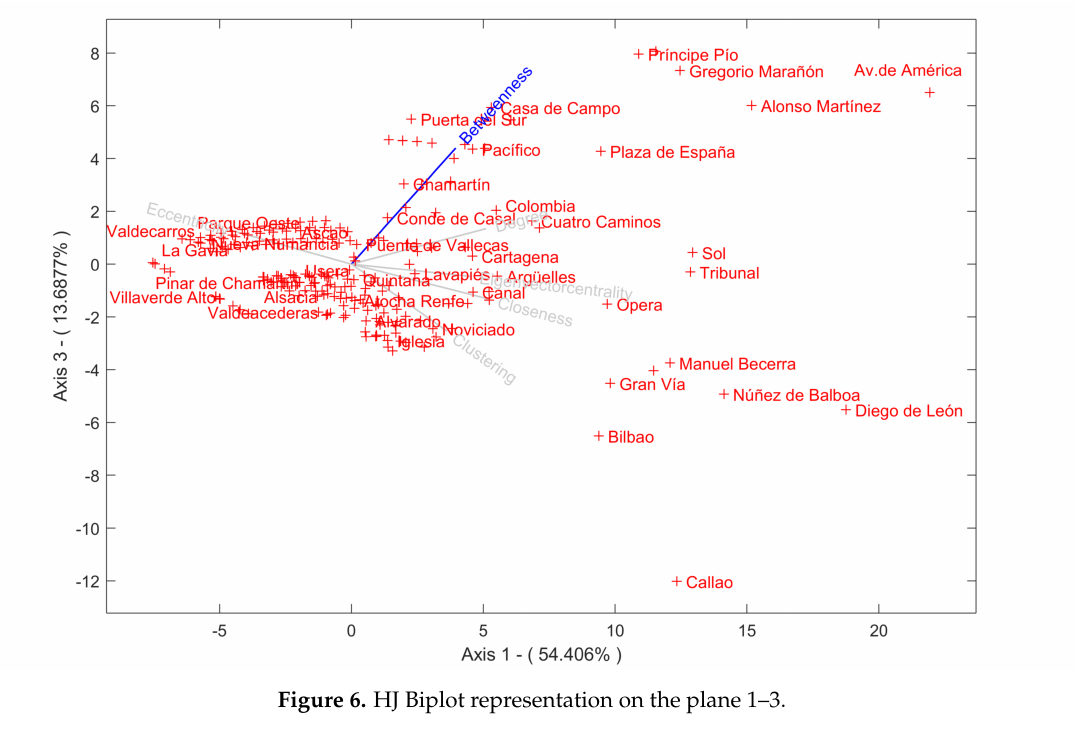
Figure 6. HJ Biplot representation on the plane 1–3.